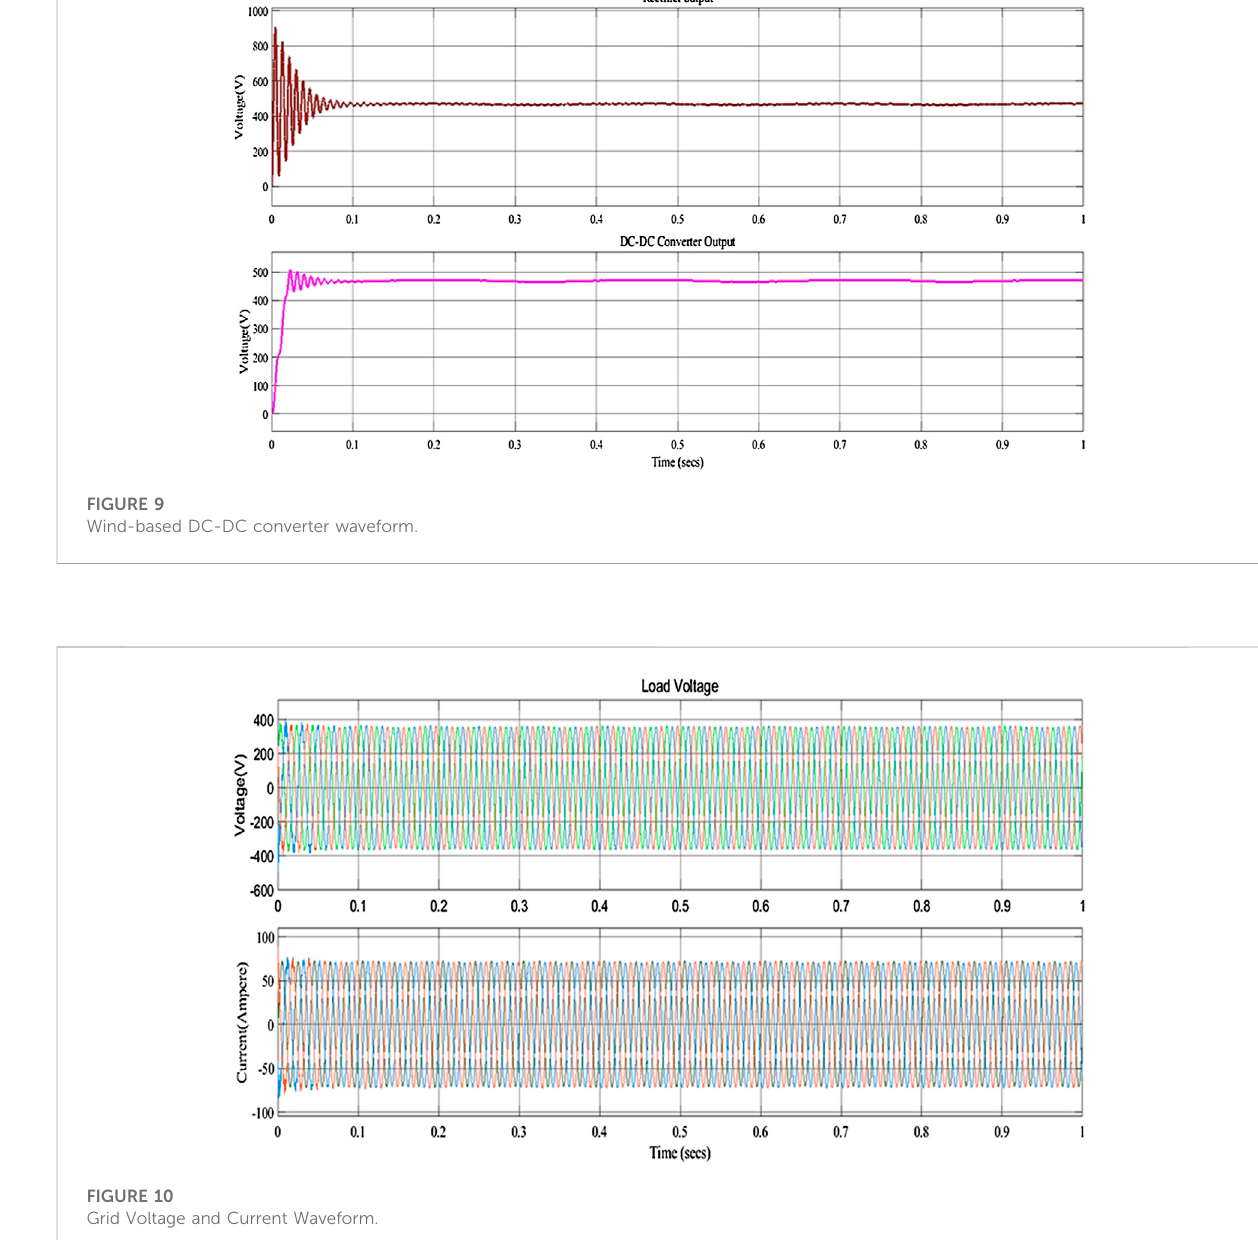
FIGURE 10 Grid Voltage and Current